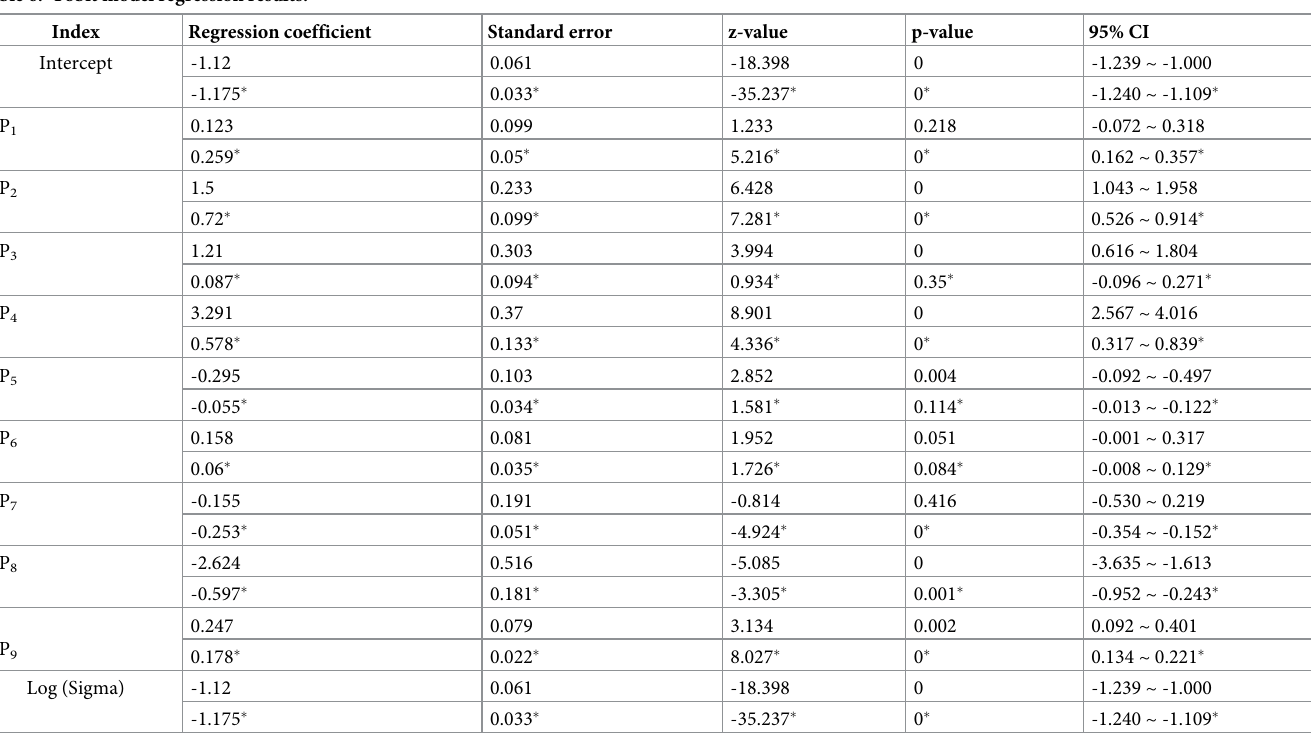
Table 6. Tobit model regression results.